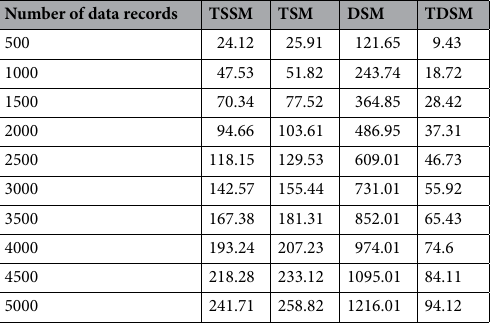
Table 3. Detailed information of storage capacities between TSSM, TSM, DSM and TDSM.